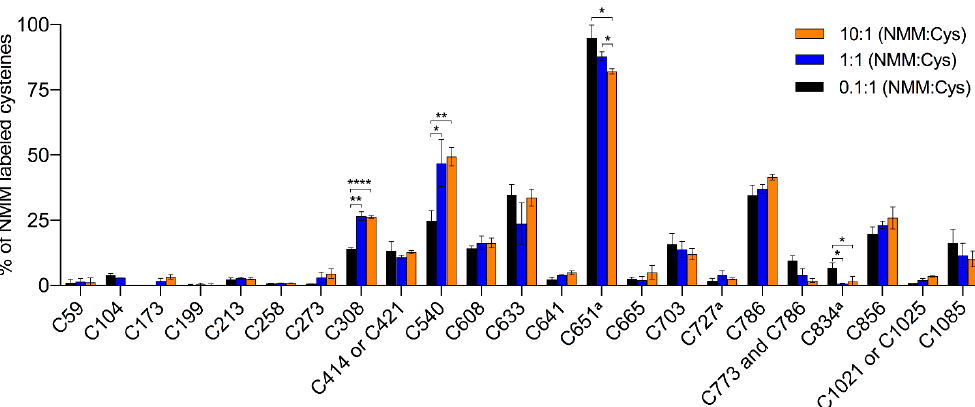
peptides are given in red with indicated y- and b-ions.